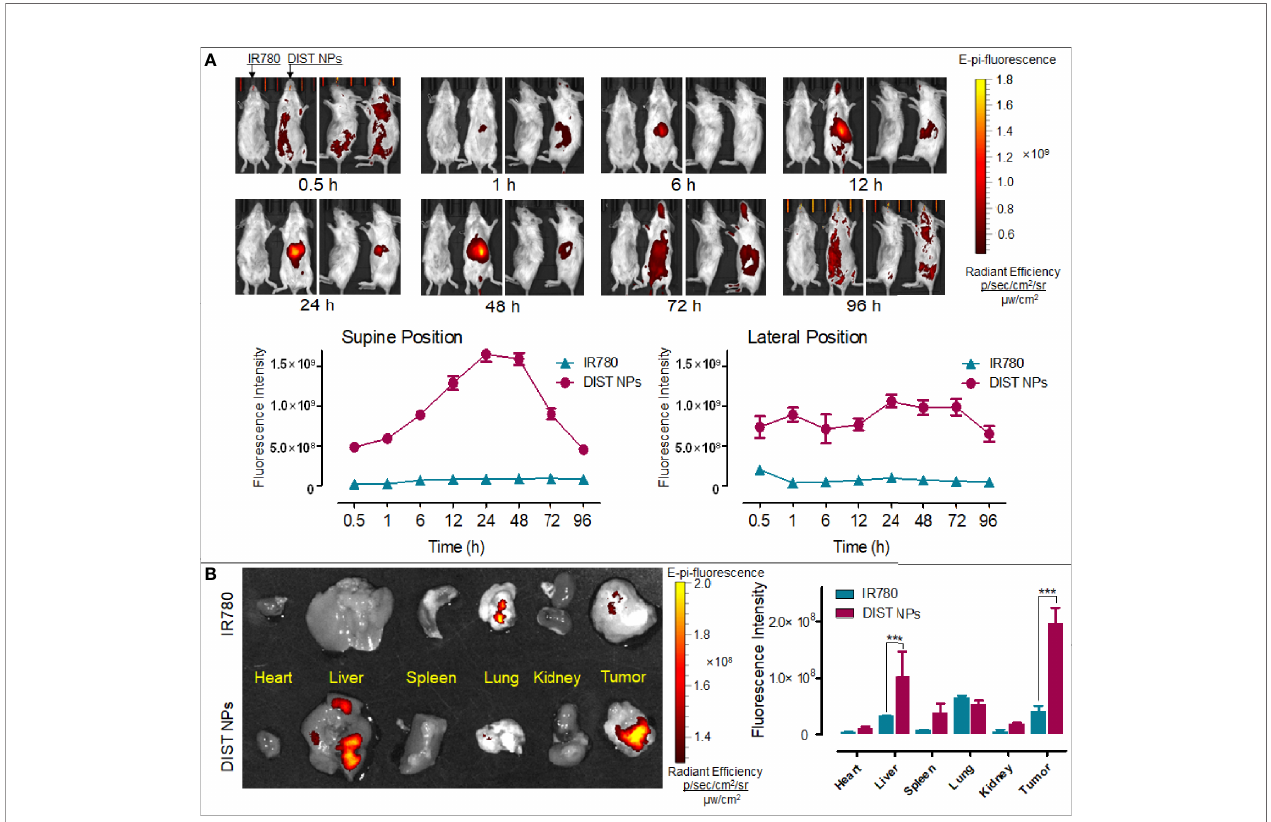
FIGURE 6 | The in vivo NIFI effects of the DIST NPs. The dynamic distributions of the NIF signal distributions of IR780 and DIST NPs in the orthotopic hepatic carcinoma model mice (A) . The photographs were taken in supine position (left) and lateral position (right), respectively. Within each position, the left photo is the IR780-treated mouse and the right one is the DIST NPs-treated one. The residual fl uorescent signals and their quantitative results in the organs and tumors of the mice (B) . The data of signal quantitation were extracted at more than three areas. The *** represents p < 0.001.